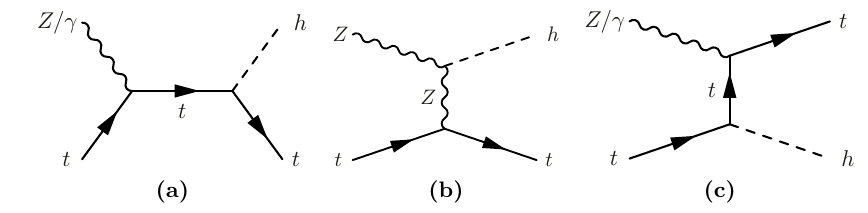
Figure 33. SM diagrams for the t Z